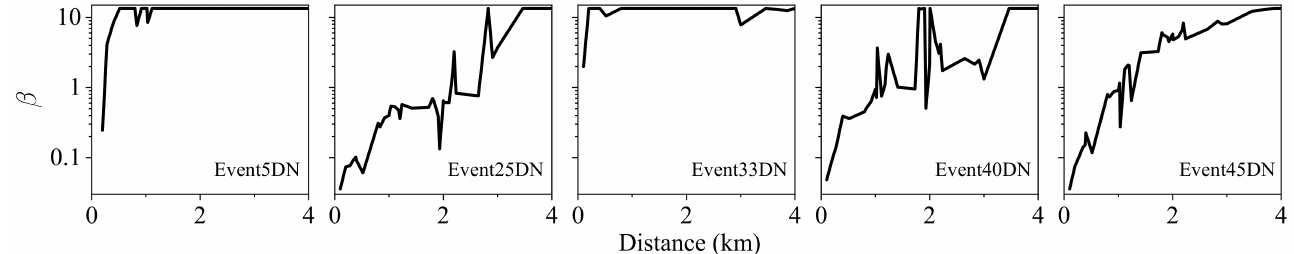
Figure 22. Identified value of β for the vertical components.